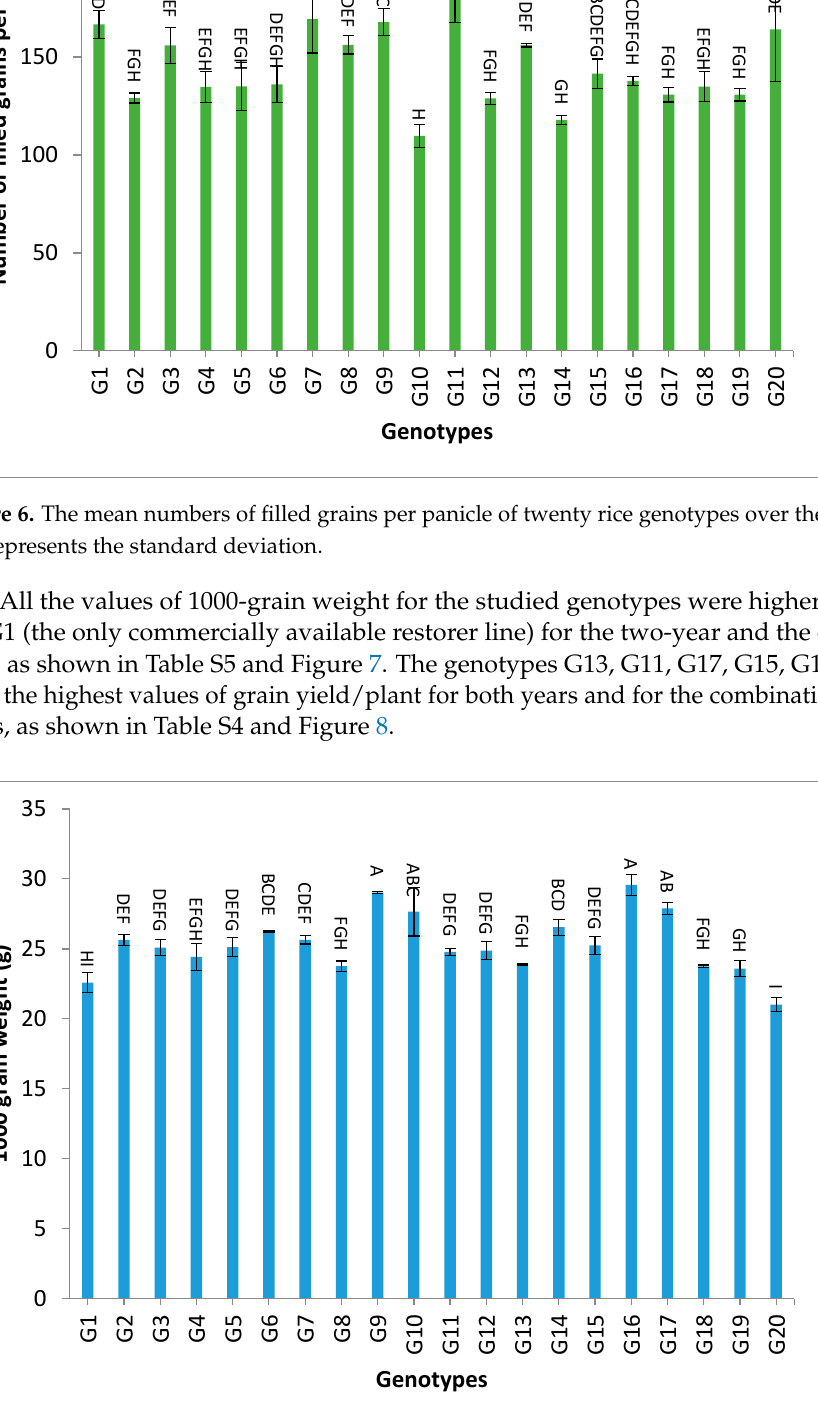
Figure 7. Mean values of 1000 grain weight (g) of twenty rice genotypes over the two years. Bar represents the standard deviation. Different alphabetic letters represent the significant differences among the genotypes at p < 0.05, based on Duncan’s multiple range test.